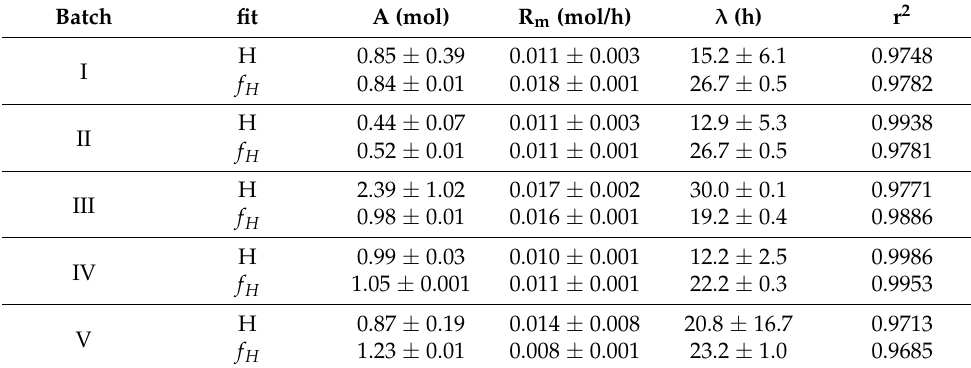
Table 2. Summary of modified Gompertz model parameters.